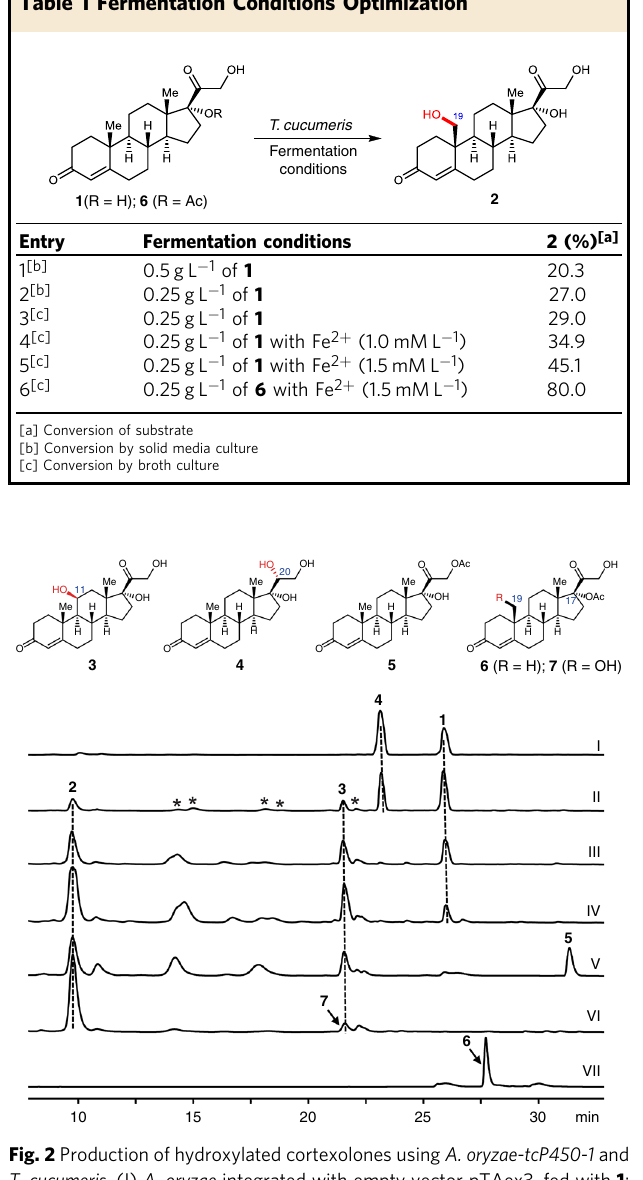
Table 1 Fermentation Conditions